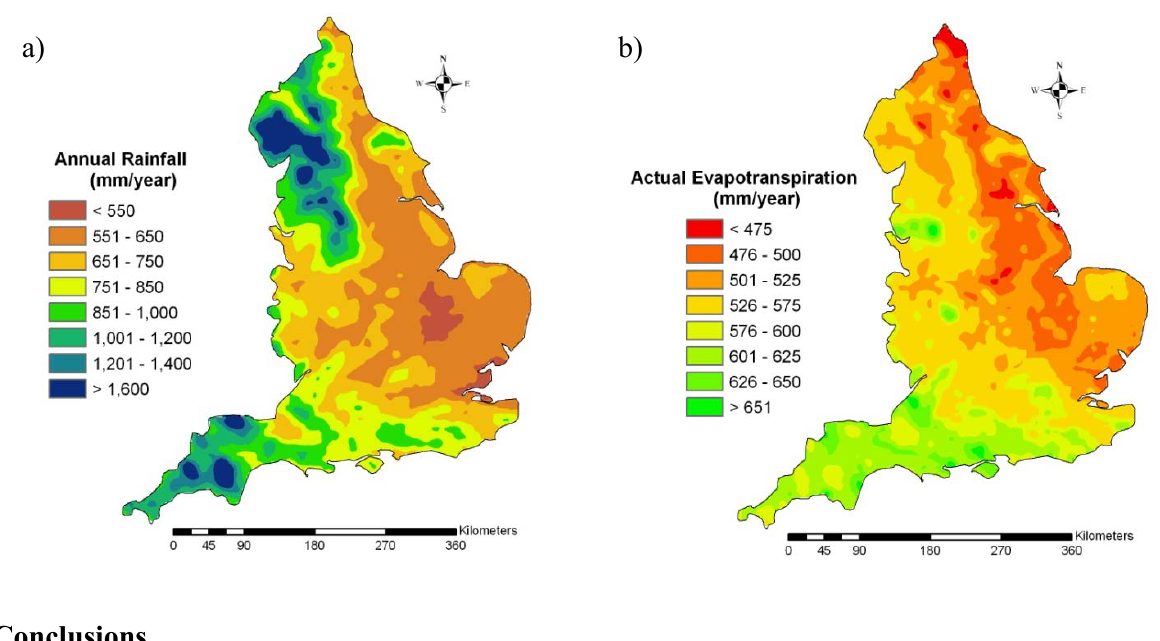
Figure 5 Map of England showing average annual a) rainfall, mm (Source: UK Climate Impacts Program) and b) estimated ET , mm for pasture in green